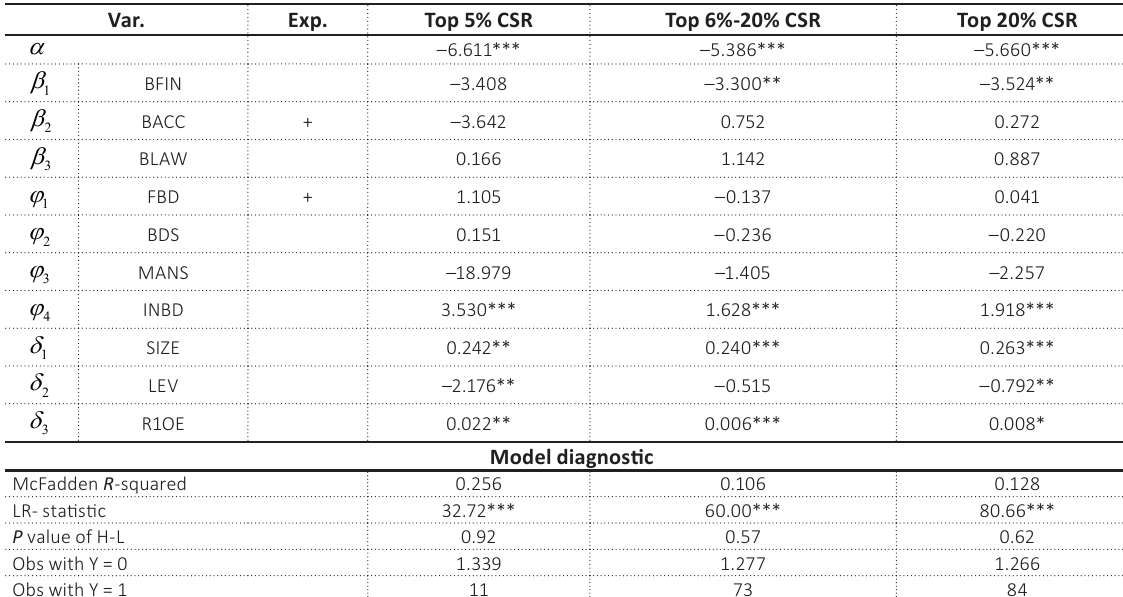
Table 7. The impact of Board gender and Accounting background on CSR (probit regression analysis for the case of less than 7 board